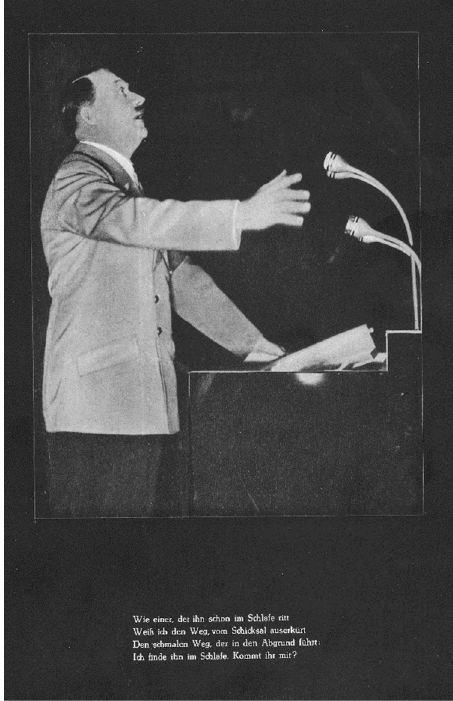
Figure 1. Brecht. 1968. Kriegsfibel. Berlin: Eulenspiegel Verlag. Bild 1.